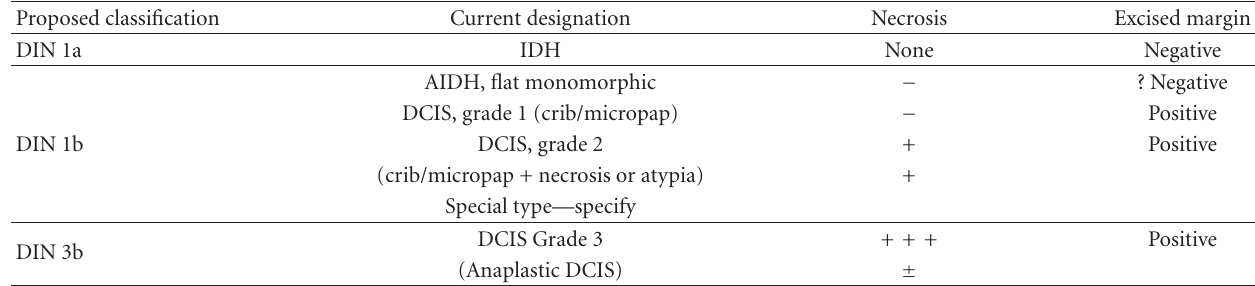
Table 1: Classification of Tavassoli